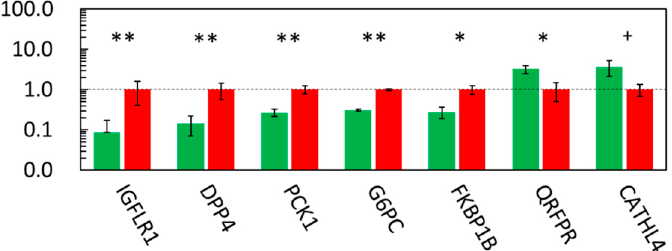
Figure 3. qPCR results of highly down- and upregulated fetal liver genes in microarray analysis. The ratios of the normalized gene expression of the LN (green) to HN (red) fetuses are shown as columns. Ribosomal protein lateral stalk subunit P0 ( RPLP0 ) was used as the internal control. Error bars indicate SEM. **, *, and + indicate differences between the LN and HN fetuses at p ≤ 0.01, ≤ 0.05, and ≤ 0.10, respectively. IGFLR1 ; IGF like family receptor 1, DPP4 ; dipeptidyl-peptidase 4, PCK1 ; phosphoenolpyruvate carboxykinase 1, G6PC ; glucose-6-phosphatase, catalytic subunit, FKBP1B ; FK506 binding protein 1B, QRFPR ; pyroglutamylated RFamide peptide receptor, CATHL4 ; cathelicidin 4.